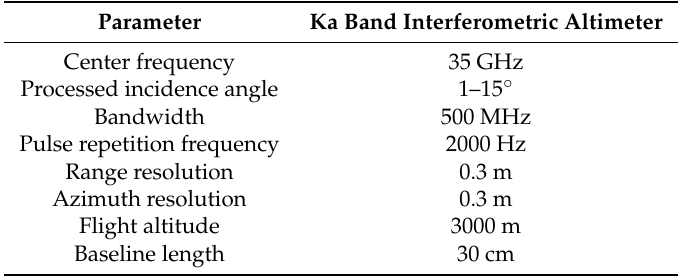
Table 1. The main parameters of the AIRAS in this